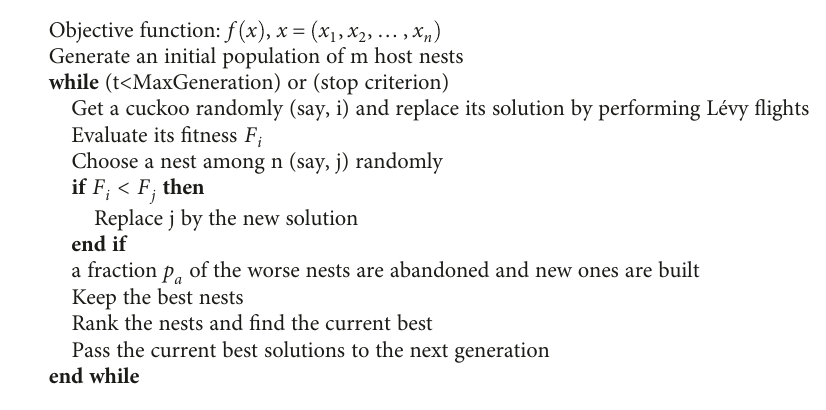
Algorithm 1: Cuckoo search